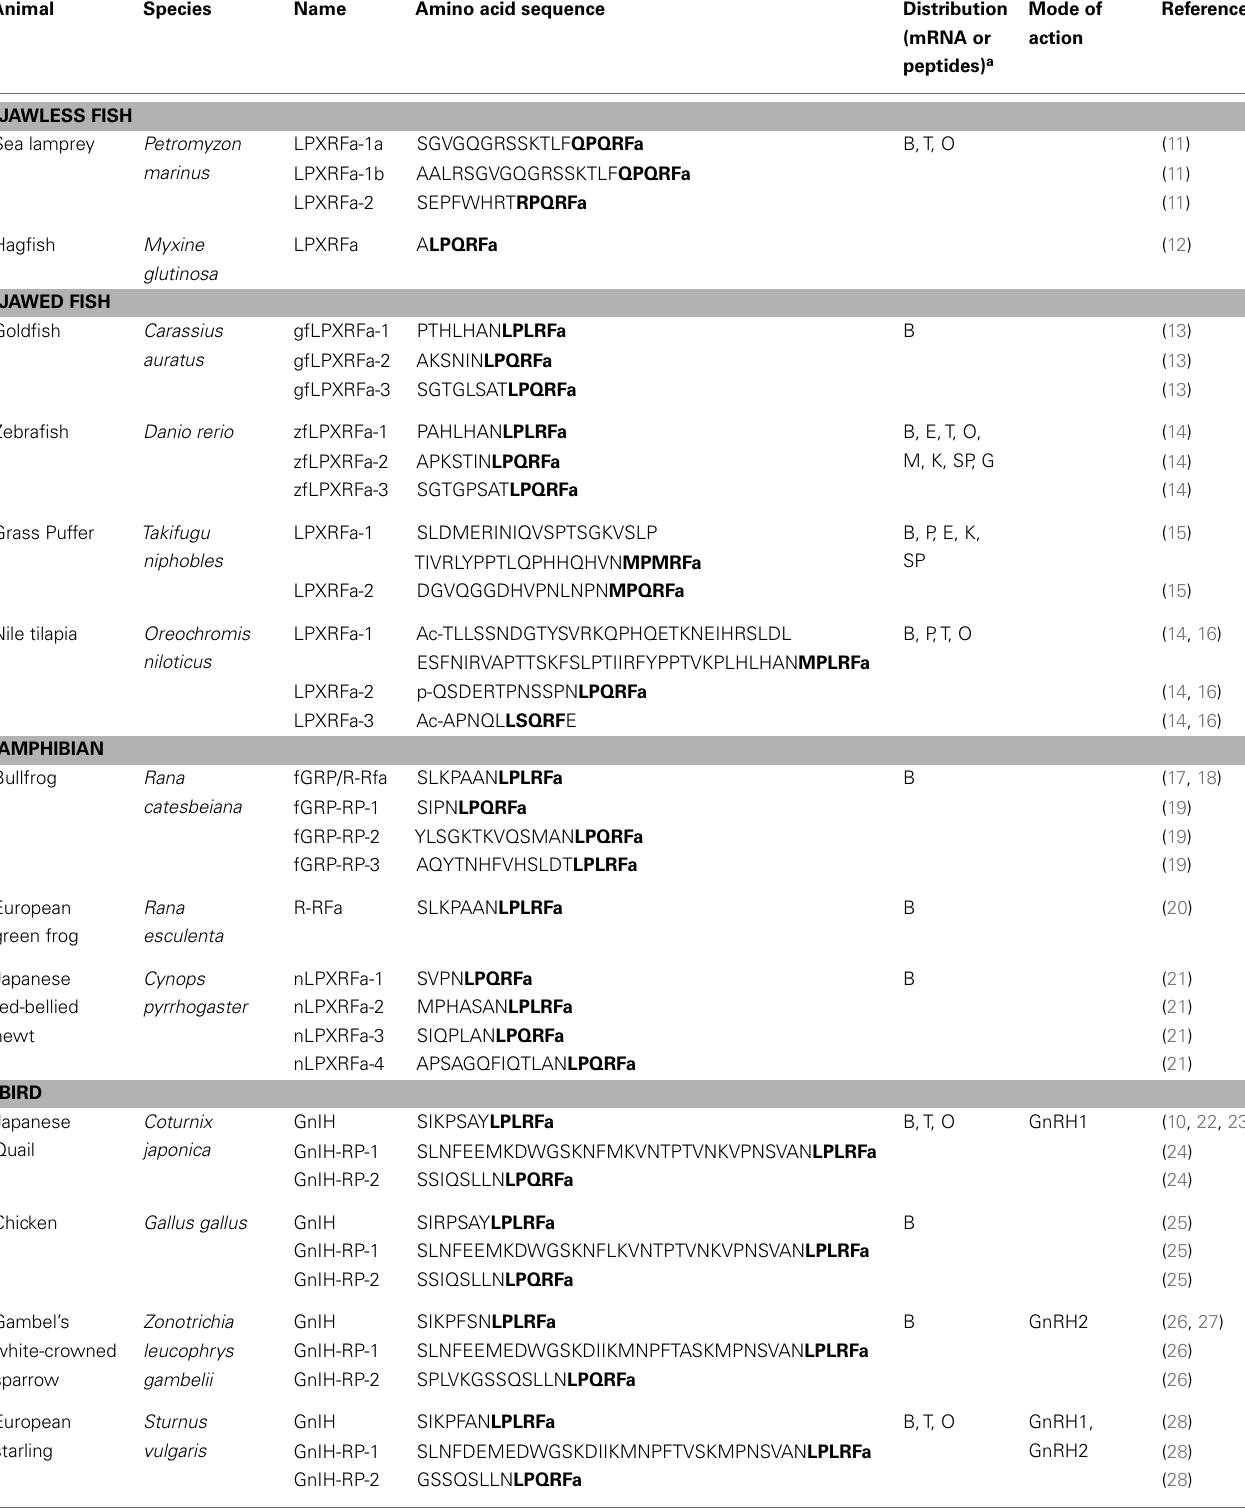
Table 1 | Comparison of amino acid sequences of GnIH and its homologous peptides from jawless fish to mammals . Animal Species Name Amino acid sequence Distribution